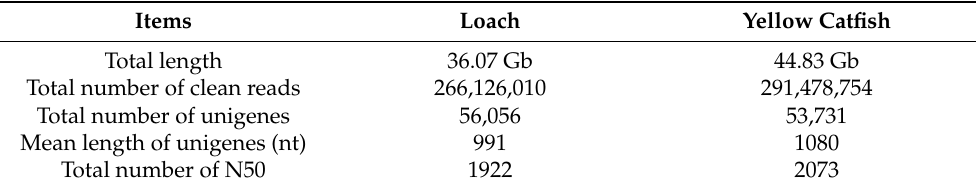
Table 1. Summary of mixed-assembling transcriptome data of loach M. anguillicaudatus and yellow catfish P. fulvidraco